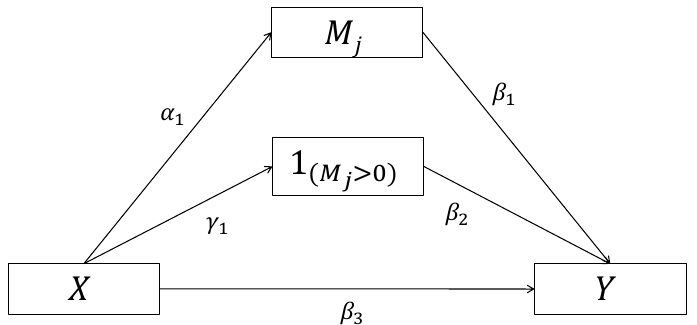
Figure 1. Potential causal mediation pathways of a zero-inflated